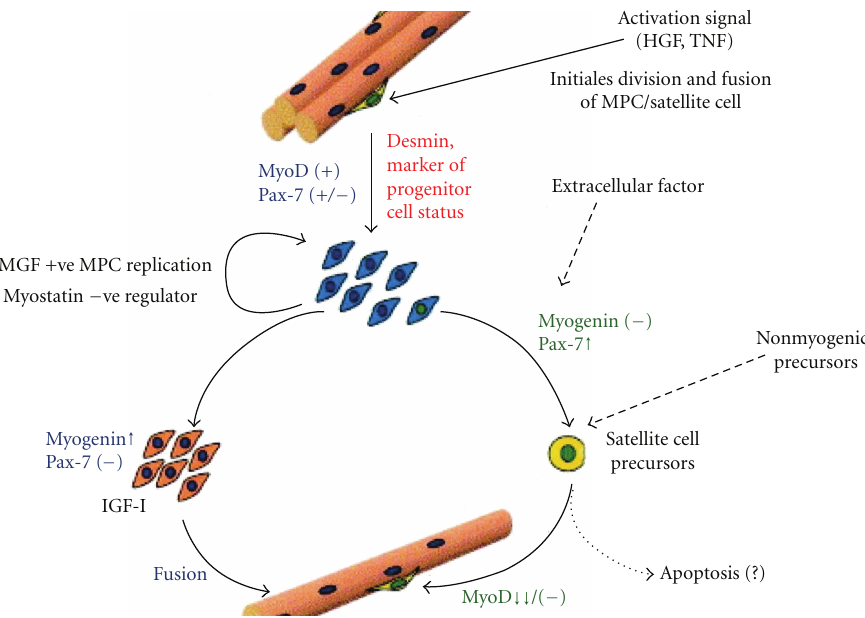
Figure 4: Illustrates role of the MGF C terminal peptide in activating the replication of the mononucleated myoblasts (otherwise termed as satellite cells or muscle progenitor/stem cells). These are the source of the extra nuclei required for local muscle repair. MGF in young normal muscle replenishes the pool of stem cells, and myostatin acts as a negative regulator and pushes then into a quiescent mode. Following the activation of the mononucleated myoblasts to undergo mitosis one of the pair will fuse with the myofiber and switch into myogenic gene expression for the production of contractile such as actin and myosin and other muscle